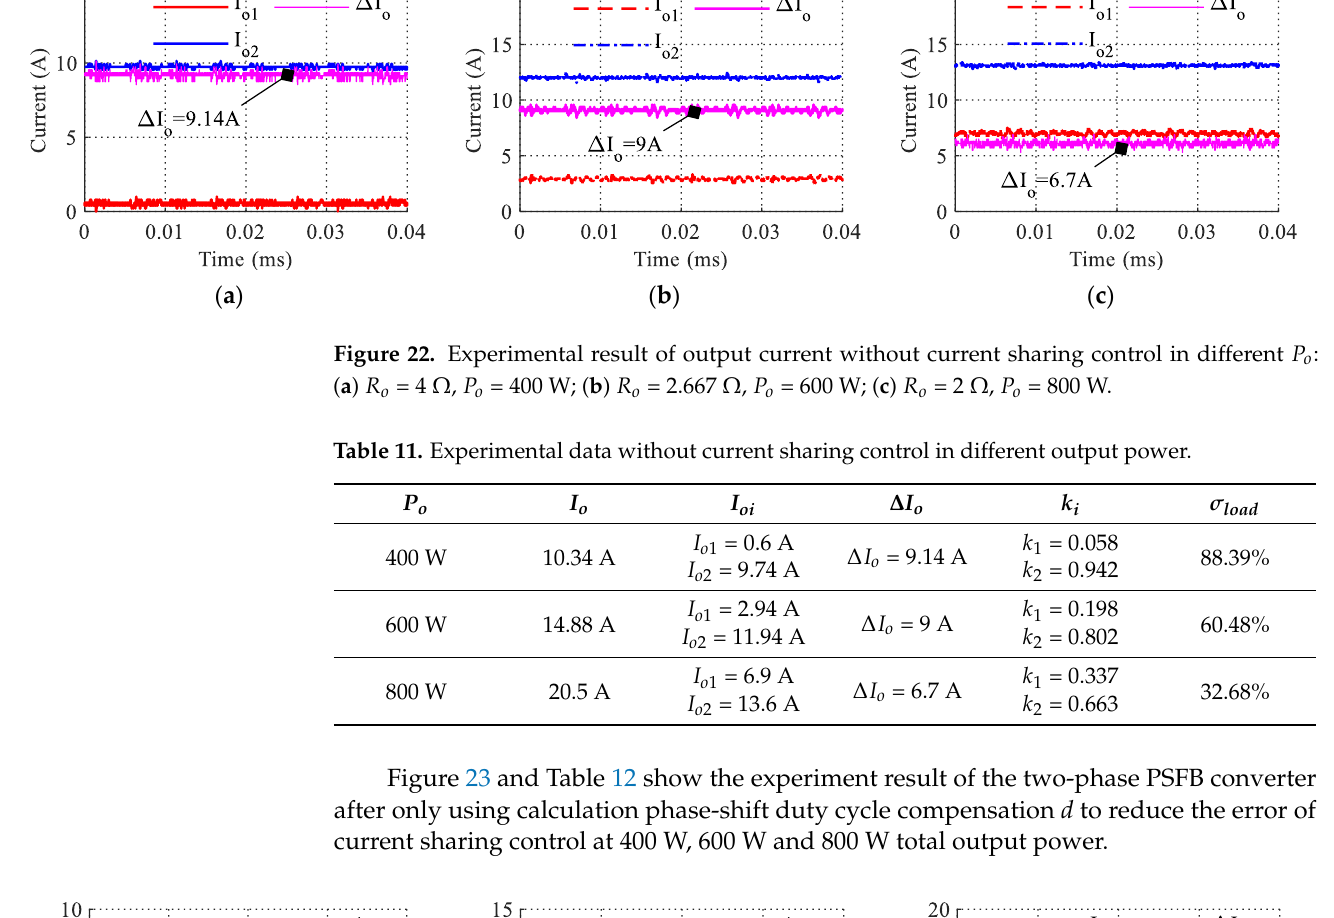
= 4  , P = 400 W; ( b ) ( a ) R o = 4 Ω , P o = 400 W; ( b ) R o = 2.667 Ω , P o = 600 W; ( c ) R o = 2 Ω , P o = 800 o